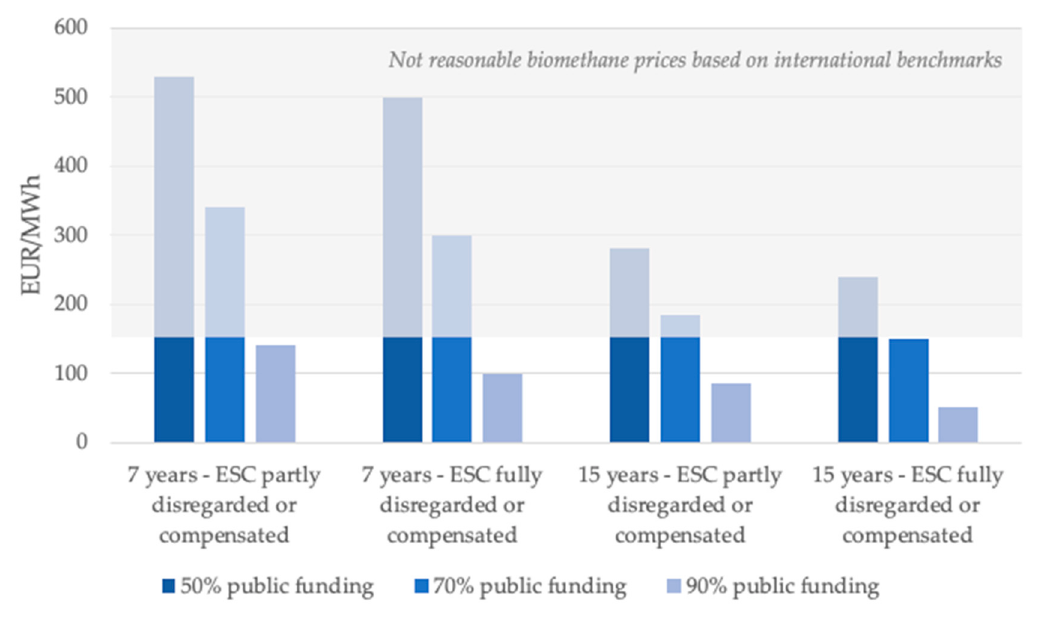
Figure 3. Biomethane prices for 7- and 15-year-long payback periods of a 1 MW el P2M plant focusing only on seasonal energy storage with 1200 operating h/year.